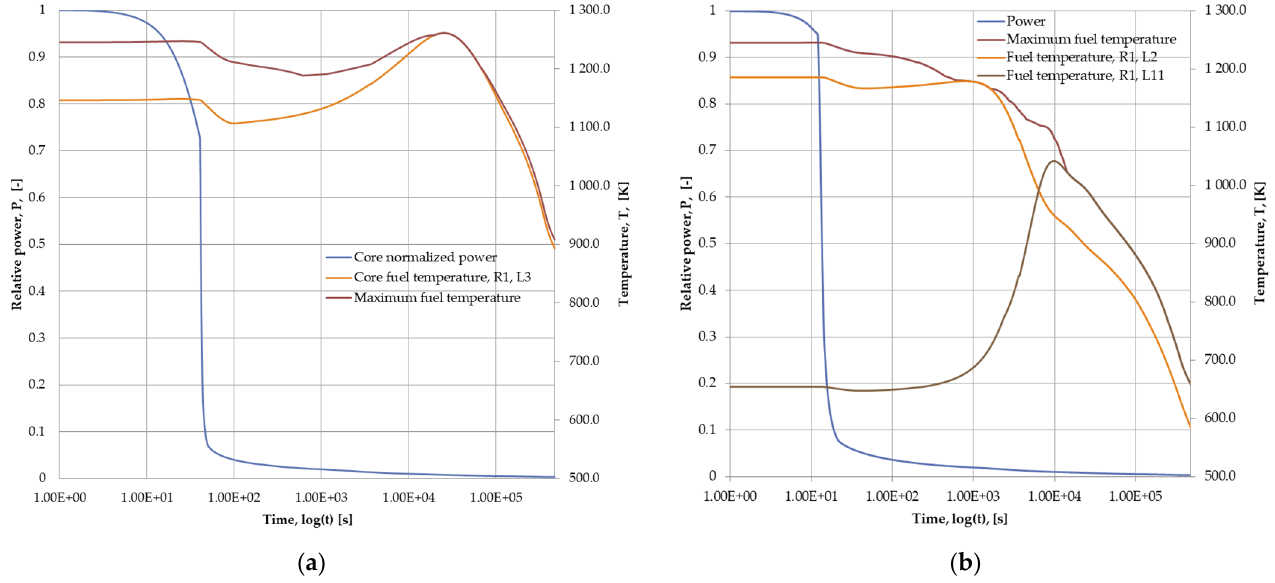
Figure 6. DLOFC ( a ) and PLOFC ( b ) accident core normalized power (P, [ − ]) and fuel maximum temperatures (T f , [K]). Table 7. MELCOR 2.2 code model qualification table at “steady-state” level.